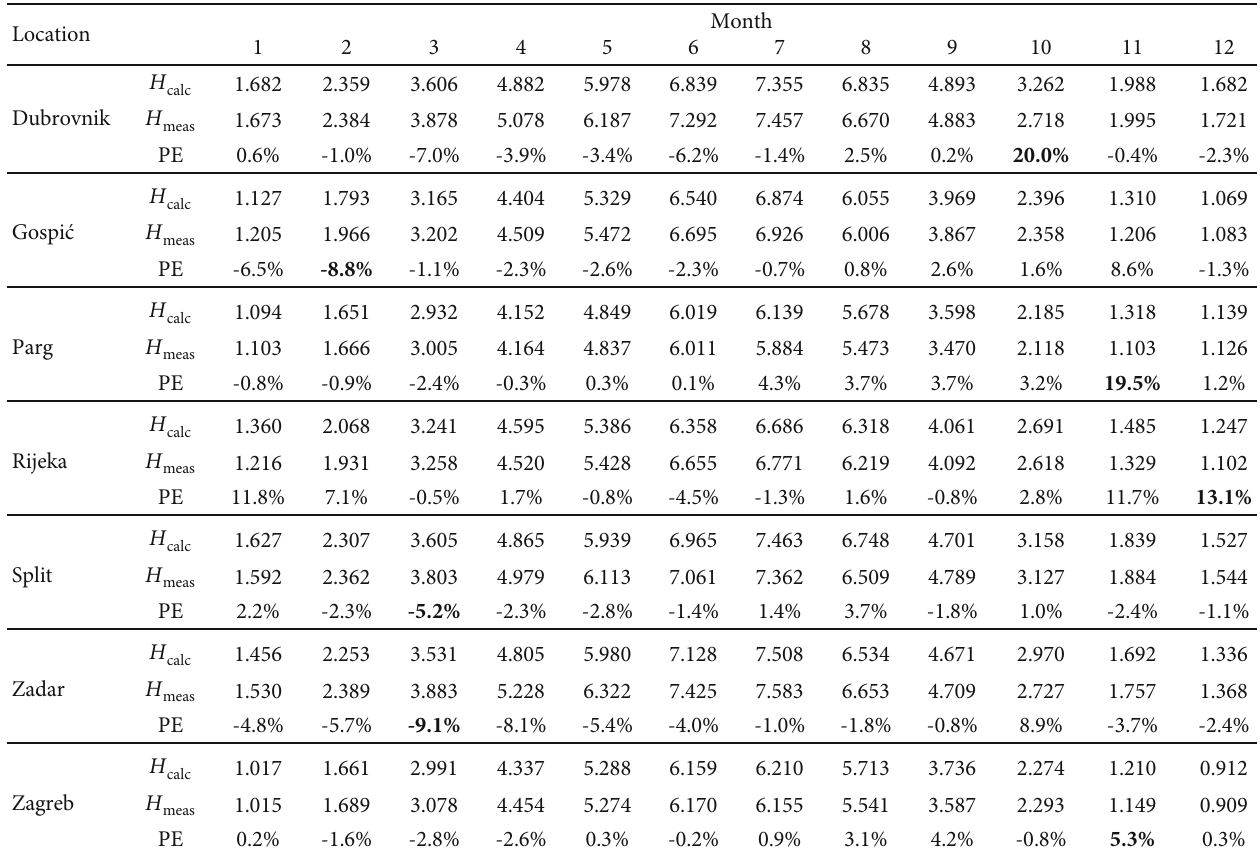
and H are in kWh/m 2 . calc meas